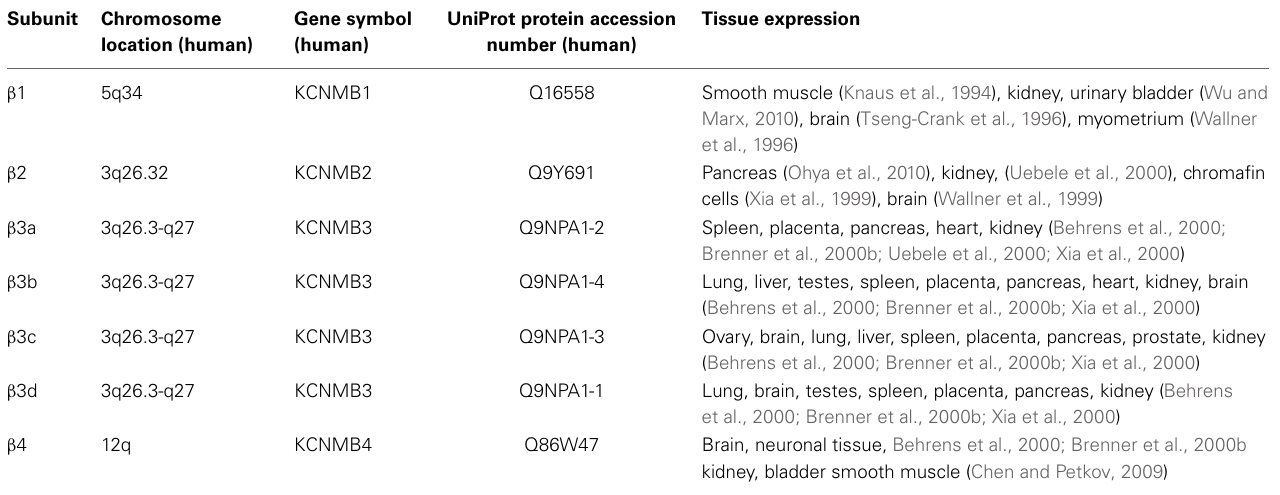
Table 1 | Tissue expression of the BK channel accessory β